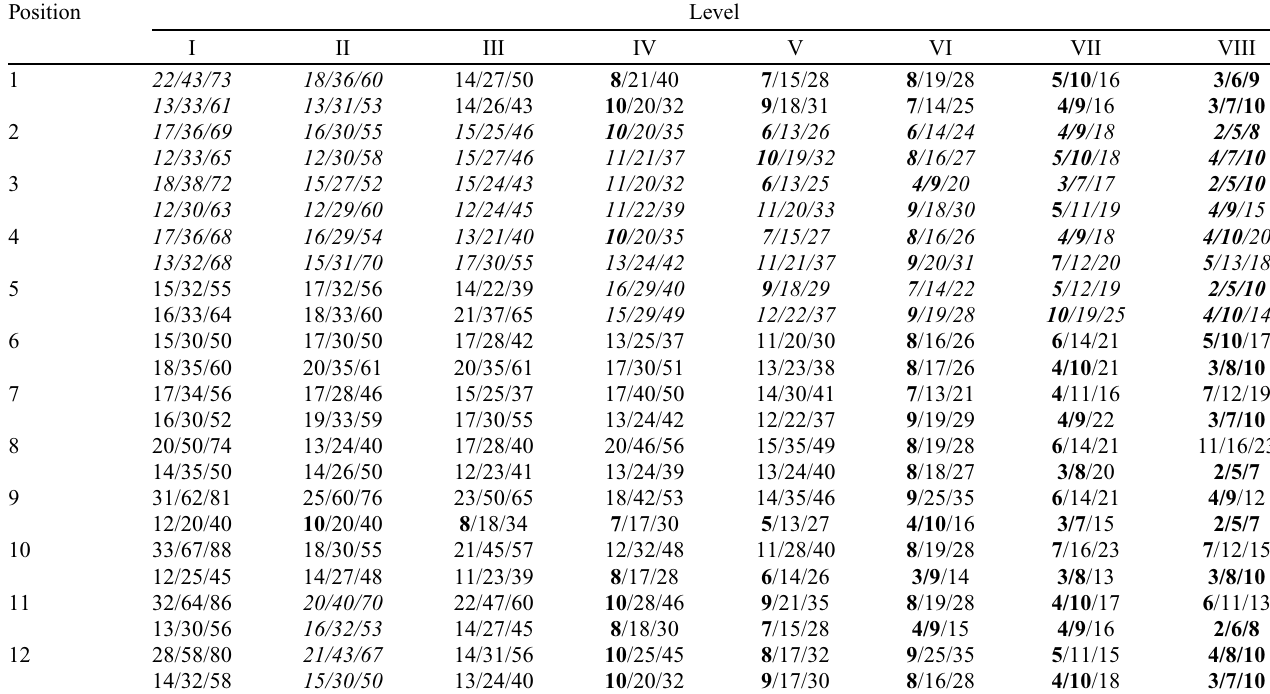
Table 4. Skin displacement [mm] relative to the radius at 10 (cid:2) /30 (cid:2) /70 (cid:2) of pronation and 10 (cid:2) /30 (cid:2) /70 (cid:2) of supination. Position